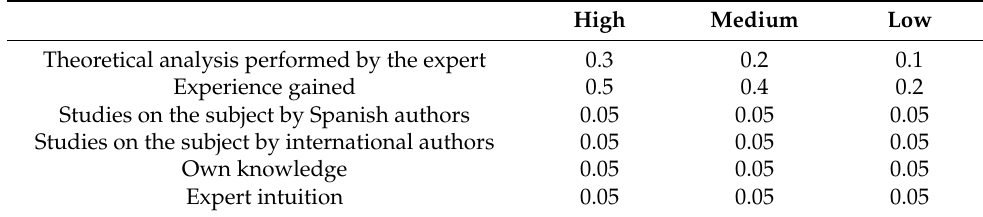
Table 1. Values used to assess the argumentation coefficient (Ka) [29].